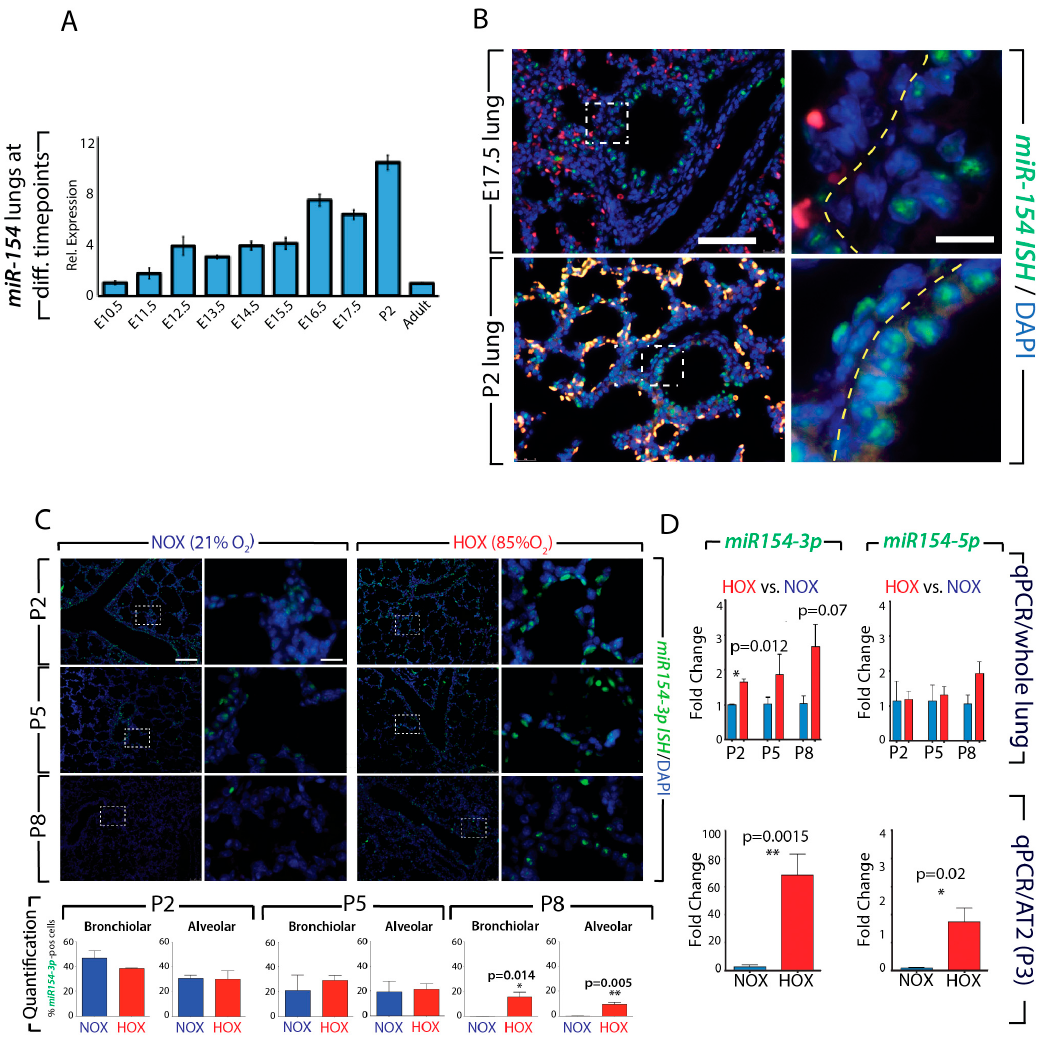
Figure 1. Expression of miR-154-3p and miR-154-5p during development and after hyperoxic lung injury: A . Expression of miR-154-3p in the lung from E10.5- adult age. B . FISH of miR-154-3p expression at E17.5 and P2. C . miR-154-3p expression in hyperoxic lung injury at P2, P5 and P8 by FISH and Quantification of miR-154-3p positive cells in bronchiolar and alveolar epithelium. D . miR-154-3p and miR-154-5p expression in whole lung and isolated AT2 cells by RT-qPCR. Please note: for each stage the expression of miR-154-3p and -5p in the hyperoxia have been normalized to the expression in normoxia. P2: NOX n = 2, HOX n = 3; P5: NOX n = 3, HOX n = 4; P8: NOX n = 3, HOX n = 3; P3: NOX n = 6, HOX n = 6. Scale bar in B: low magnification: 120 µ m; high magnification: 30 µ m. Scale bar C: low magnification: 180 µ m; high magnification: 45 µ m. * p ≤ 0.05, ** p ≤ 0.01, *** p ≤ 0.001, **** p ≤